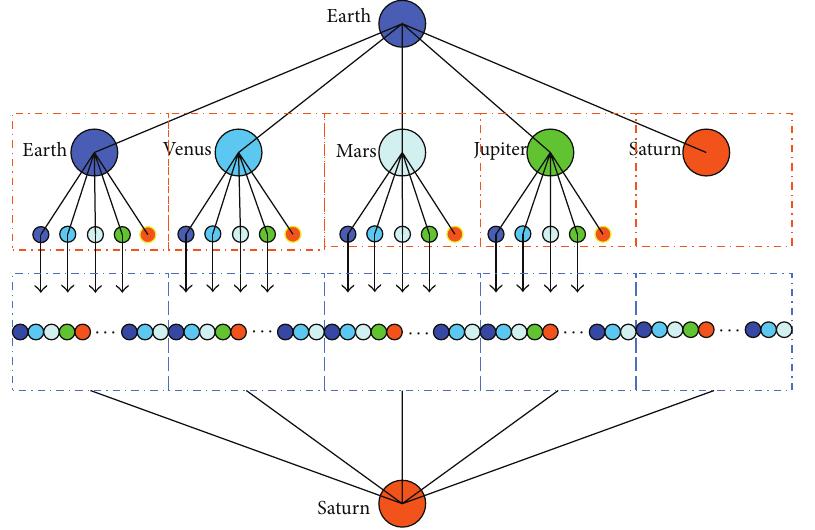
Figure 2: Tree searching with